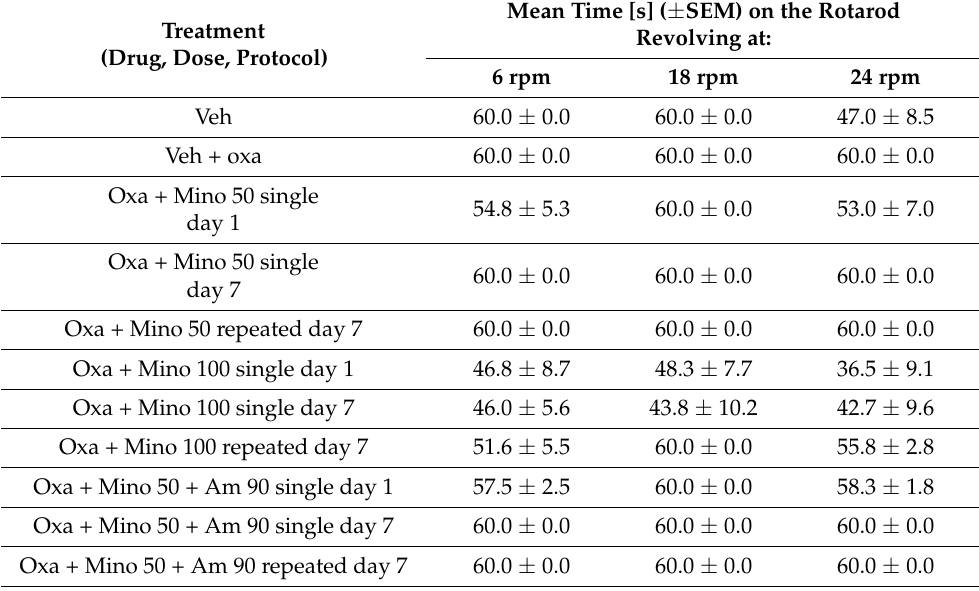
Table 1. Effect of test drugs administered in a single-dose or repeated-dose protocol and used alone or in combination on motor coordination of oxaliplatin-treated mice measured in the rotarod